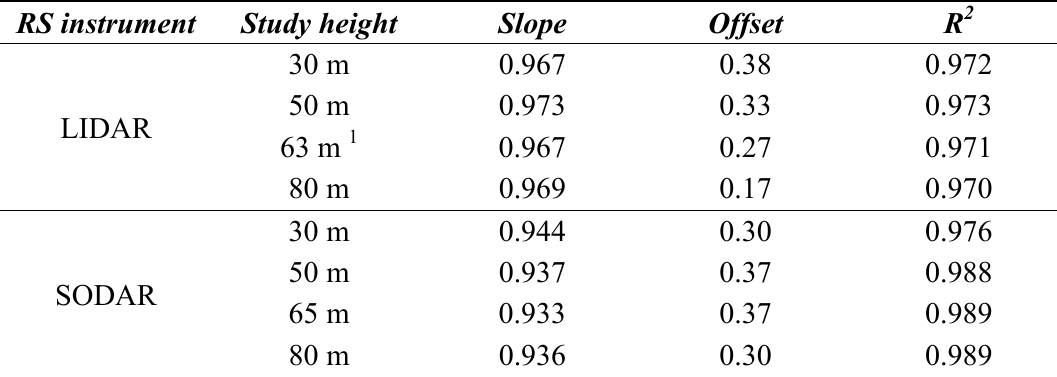
Table 2. Regression Results for Wind Speed